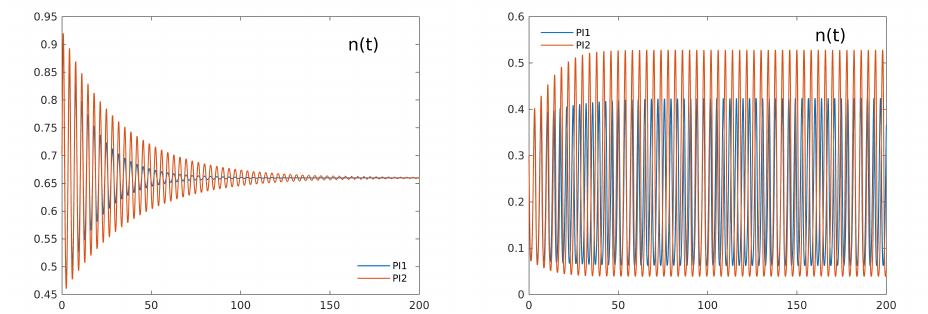
Figure 1. Trajectories for the numerical approximations PI1 and PI2 of n ( t ) solution of system (3) for θ = 1 in case of a stable equilibrium ( left panel ) and in the presence of Hopf instability ( right panel ). The lowest order approximation PI1 clearly shows damped oscillations, while the trajectories of the higher order approximations are in excellent agreement with the ones obtained by classical ODE solvers.